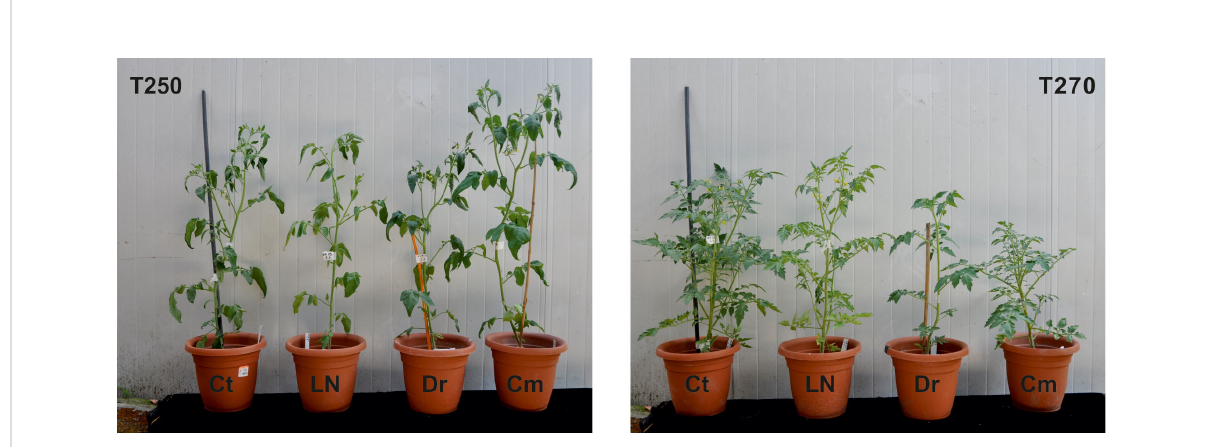
FIGURE 3 Representative plants of genotypes T250 (left) and T270 (right) grown for 24 days in Control (Ct), Low Nutrient (LN), Drought (Dr) or Combined stress (Cm)